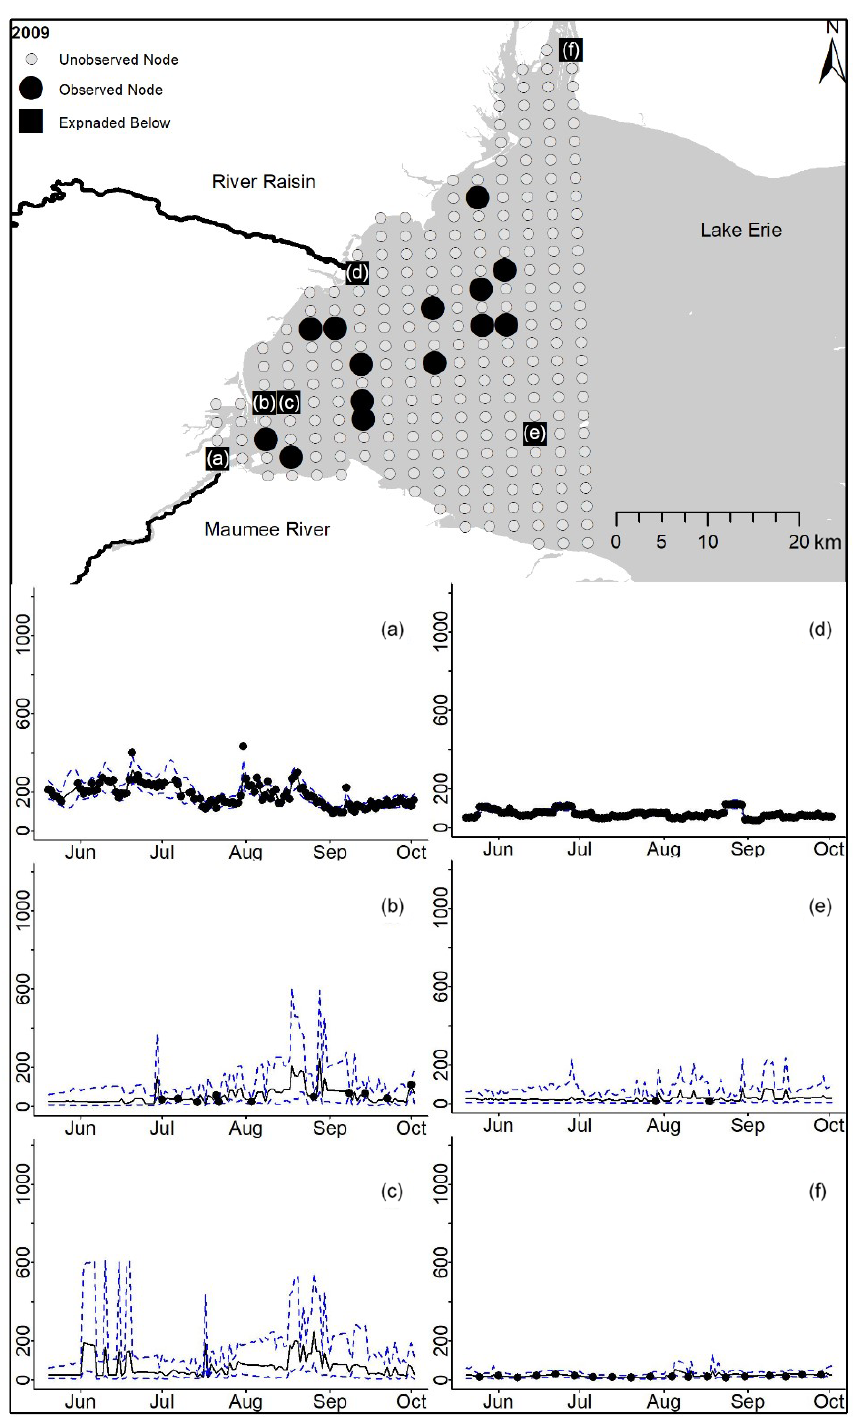
Figure D2. For 2009 the total phosphorus concentrations (µgL − 1 ) at observed and unobserved nodes were estimated from the model posterior samples. Mean (solid black line) and 95%PI (dashed blue line) for the model posterior samples of each node at every day for (a) the Maumee River, (b, c, e, f) western Lake Erie nodes, and (d) the Raisin